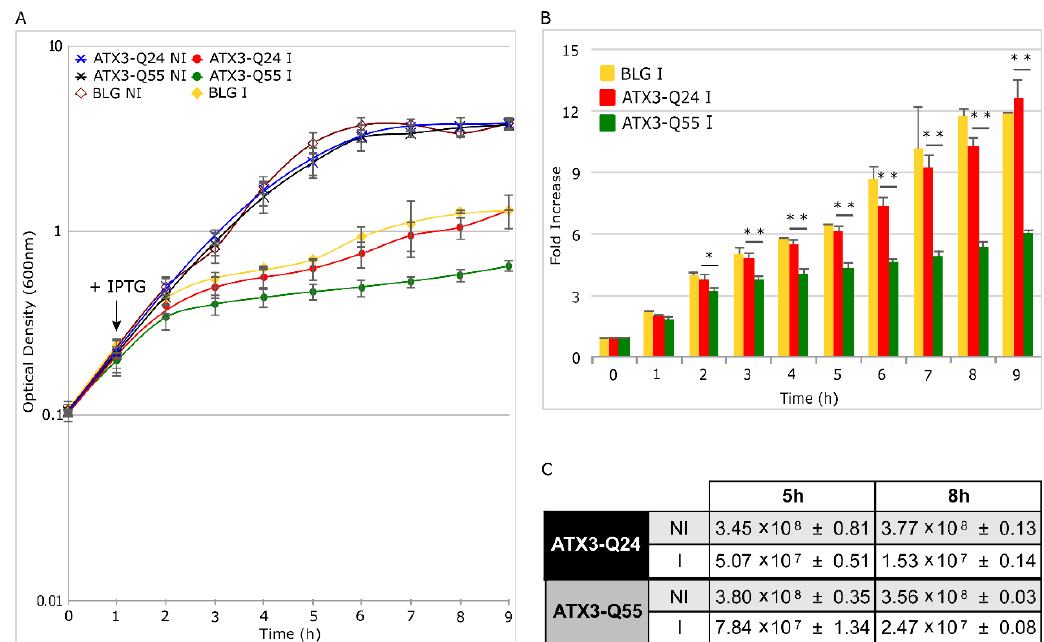
Figure 1. Effects of ataxin-3 (ATX3) variants expression on cell growth and viability. ( A ) Growth curves of E. coli Rosetta strains expressing ATX3-Q24 (black dots), ATX3-Q55 (light grey dots) and β -lactoglobulin (BLG) (grey squares). Cultures were inoculated at OD 600 = 0.1 (t0), induced after 1 h with 0.4 mM of IPTG (t1, black arrow) and growth profiles were monitored at 37 °C for 8 h. As control, the same cultures (ATX3-Q24, black stars; ATX3-Q55, light grey stars; BLG, not filled grey squares) were inoculated without IPTG addiction (Not Induced, NI). Error bars represent standard deviations and are obtained from nine independent experiments. ( B ) Quantification of optical density increases. Bars represent the fold increases of E. coli Rosetta stains growth expressing ATX3-Q24 (black bars), ATX3-Q55 (light grey bars) and BLG (grey bars) normalized on t0 of each strain. Error bars represent error standard and are derived from nine independent experiments. Statistical analysis was made between BLG and ATX3-Q24 strains and did not show significance. ** p -value < 0.01, * p -value < 0.05. ( C ) Colony Formation Unit (CFU) count of ATX3-Q24 and ATX3-Q55 I and NI strains. At 5 and 8 h after IPTG induction, 1 mL of cell cultures were collected, normalized at OD 600 = 0.5 and 1:10 serial dilutions were performed. Moreover, 100 µL of 10 − 6 and 10 − 5 dilutions were seeded on single LB agar plate supplemented with ampicillin 100 µg/mL and glucose 0.1%. After drying, colonies were let to growth over-night at 37 °C and then counted. Data were represented as CFU/mL with standard deviations of three independent experiments.